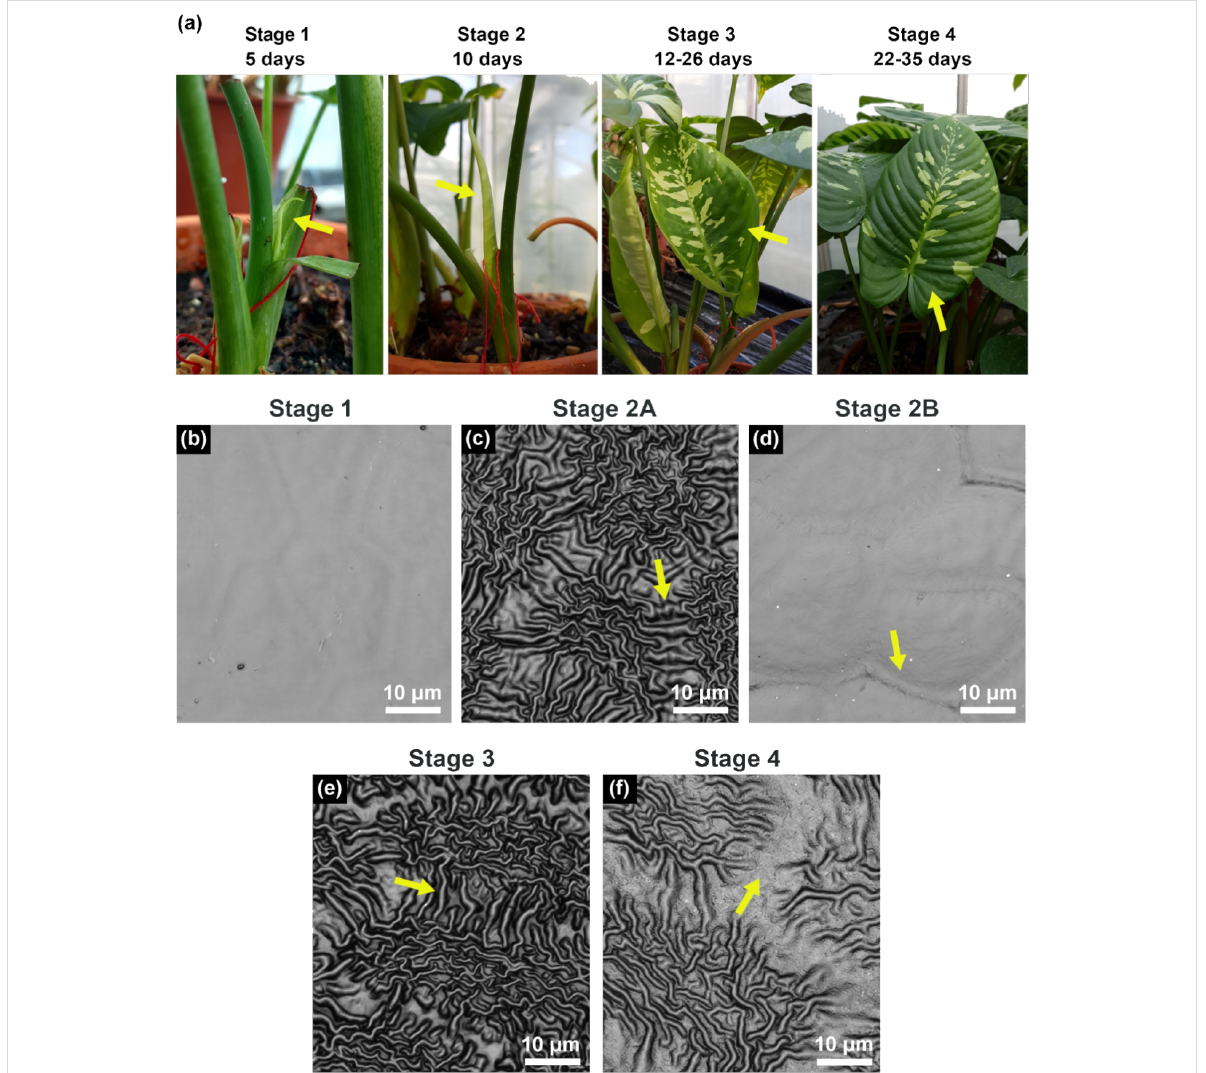
Figure 1: Leaf ontogeny and cuticular ridge development. (a) Leaf development from bud appearance during the various ontogenetic stages in Schismatoglottis calyptrata. (b–f) CLSM images of leaf replica surfaces during the different ontogenetic stages. Leaf surfaces contained smooth cells at stage 1 and stage 2B, high aspect ratio zig-zag shaped ridges at stages 2A and 3, and less dense and low aspect ratio ridges at stage 4. Arrows in- dicate: (a) leaves at the respective stages; (c) and (e) thick and long ridges connecting the peripheries of the adjacent cells; (d) a ridged structure along the anticlinal field; (f) the anticlinal field free of